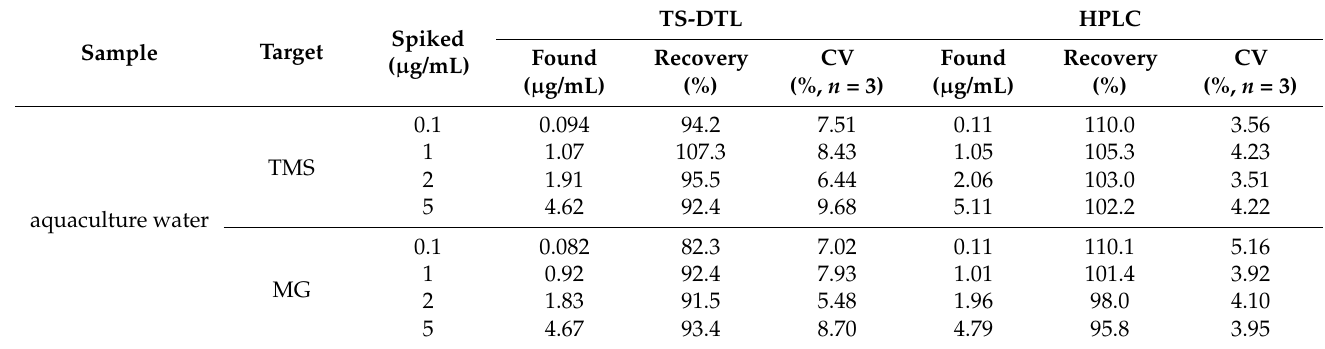
Table 2. Recovery evaluation of aquaculture water by the developed TS-DTL and HPLC methods.